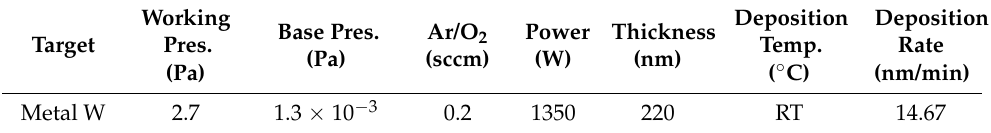
Table 2. Deposition parameters of the WO 3 films.